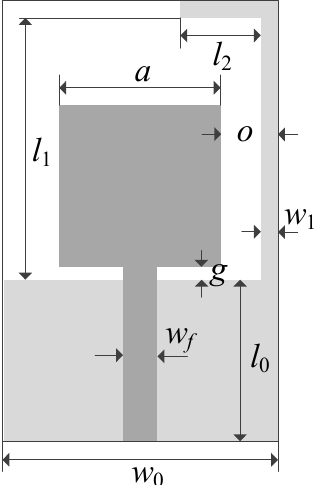
Figure 8. Geometry of Antenna III: the light gray shade is the ground plane on the backside of the structure.